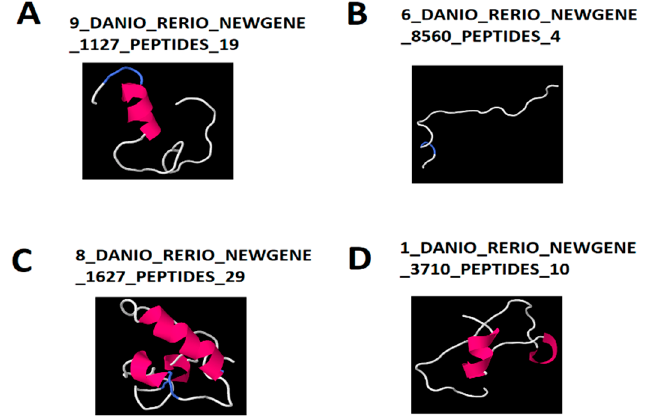
Figure 8. Three-dimensional structures predicted by the (PS)2-v2 Protein Structure Prediction Server for the lncRNA-encoded peptides simultaneously observed in zebrafish larvae, pineal gland and testis. Zebrafish lncRNA-encoded peptides coexpressed in larvae (DD condition), pineal gland, and testis ( A – C ), and Zebrafish lncRNA-encoded peptide coexpressed in larvae (LL condition), pineal gland, and testis ( D ). The 3D structures of the peptides depict the presence of α -helix (pink or purple motif structure), β -strand (yellow layered band), and random coils (white or blue thread) among the coexpressing lncRNA- encoded peptides with the known domains from Protein Data Bank such as, A (1vg5A), B (1gxrA), C (2iftA), and D (1kpfA).